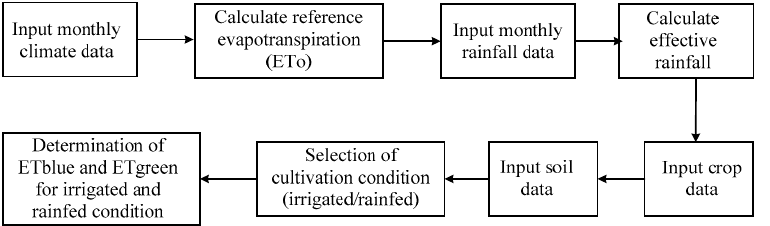
Figure 1. Flow diagram for major steps of CROPWAT 8 to calculate crop water evapotranspiration [30].